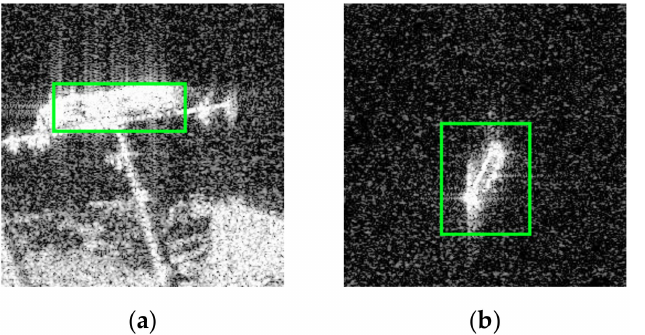
Figure 1. Localization errors in SAR ship detection. ( a ) The box does not contain the ship completely. ( b ) The box does not hold the ship